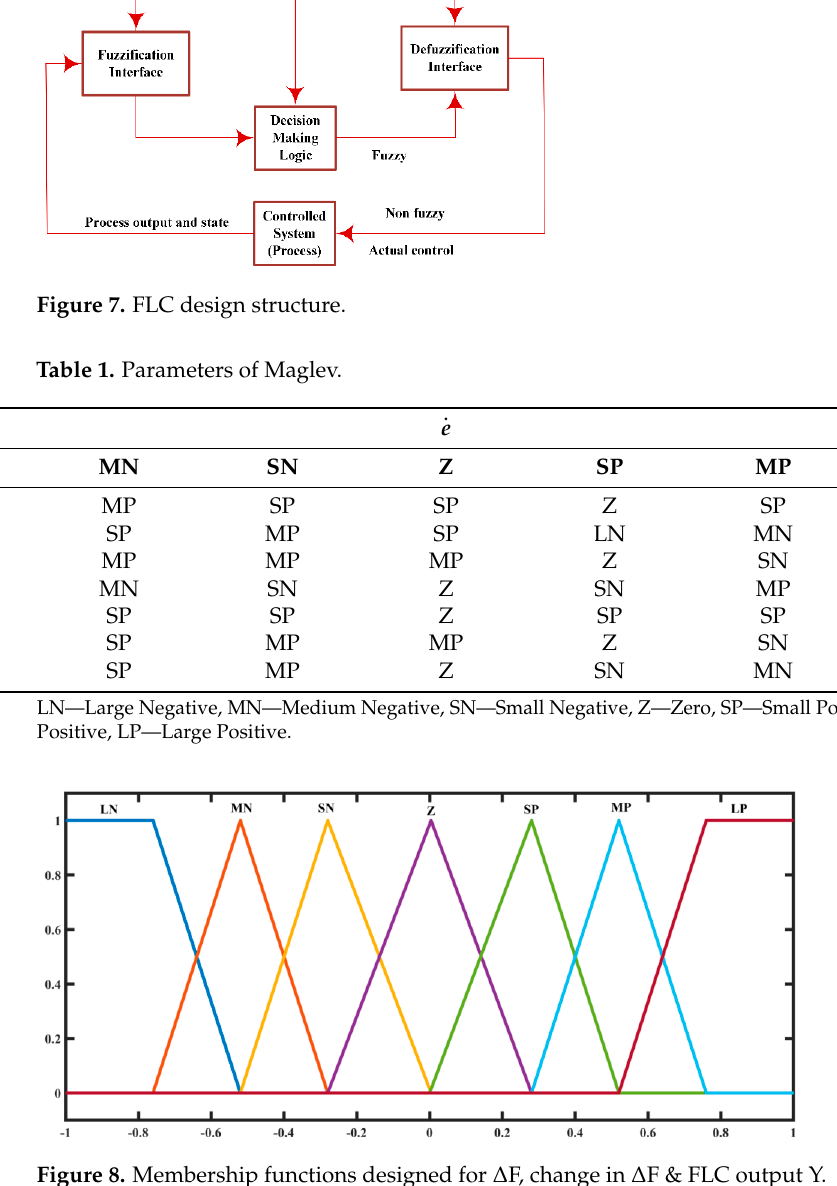
Figure 8. Membership functions designed for ∆ F, change in ∆ F & FLC output Y.